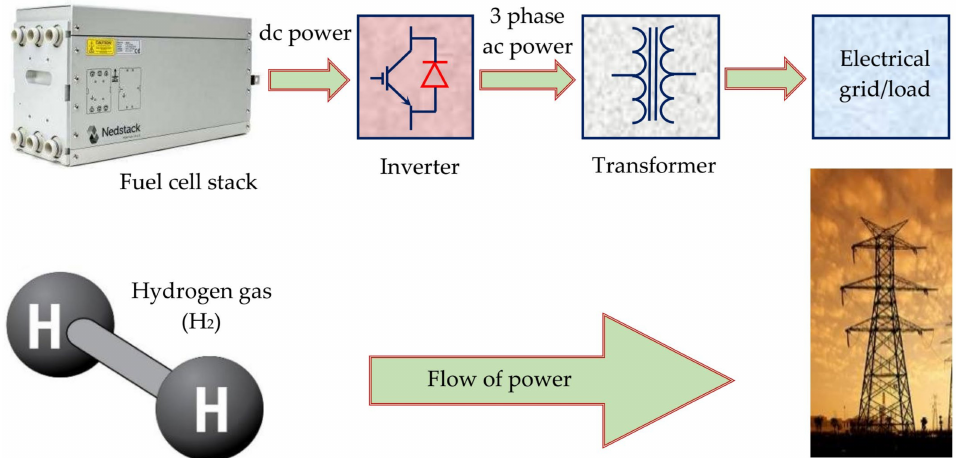
Figure 1. Schematic diagram of the proton exchange membrane fuel cell (PEMFC) connected to a